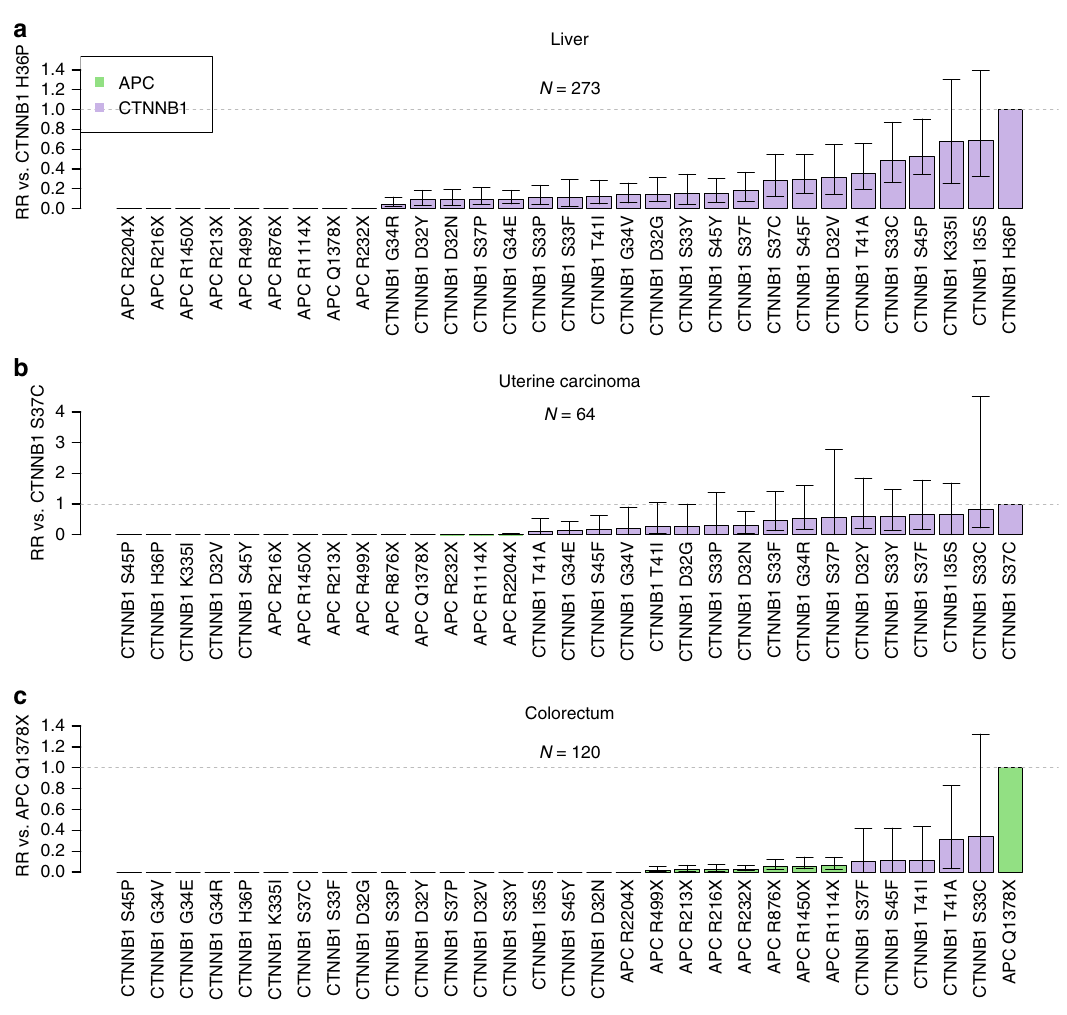
Fig. 5 Evidence for differential selection between mutations in APC and CTNNB1 . a liver cancer, b uterine carcinoma and c colorectum. Con fi dence intervals obtained by bootstrapping across 100 iterations. Error bars represent 95% con fi dence intervals obtained by bootstrapping across 100 iterations. N indicates total number of samples used for the analysis within each cancer (Fig. 5c). We note that this mutation, APC Q1378X , falls within the functionally de fi ned mutation cluster region of the gene 19 .